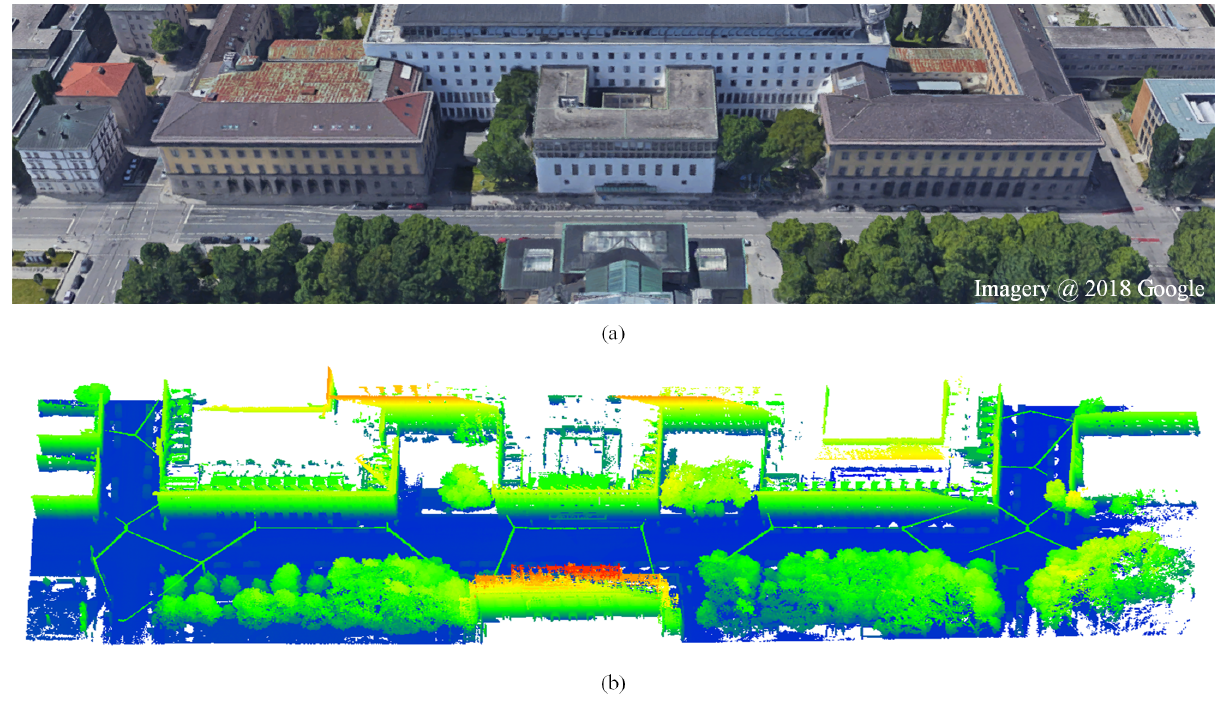
Figure 1. Illustration of the test area in experiments. (a) Image scene of Arcistrasse facing the TUM main entrance from Google maps, 2018. (b) MLS point cloud colored regarding to